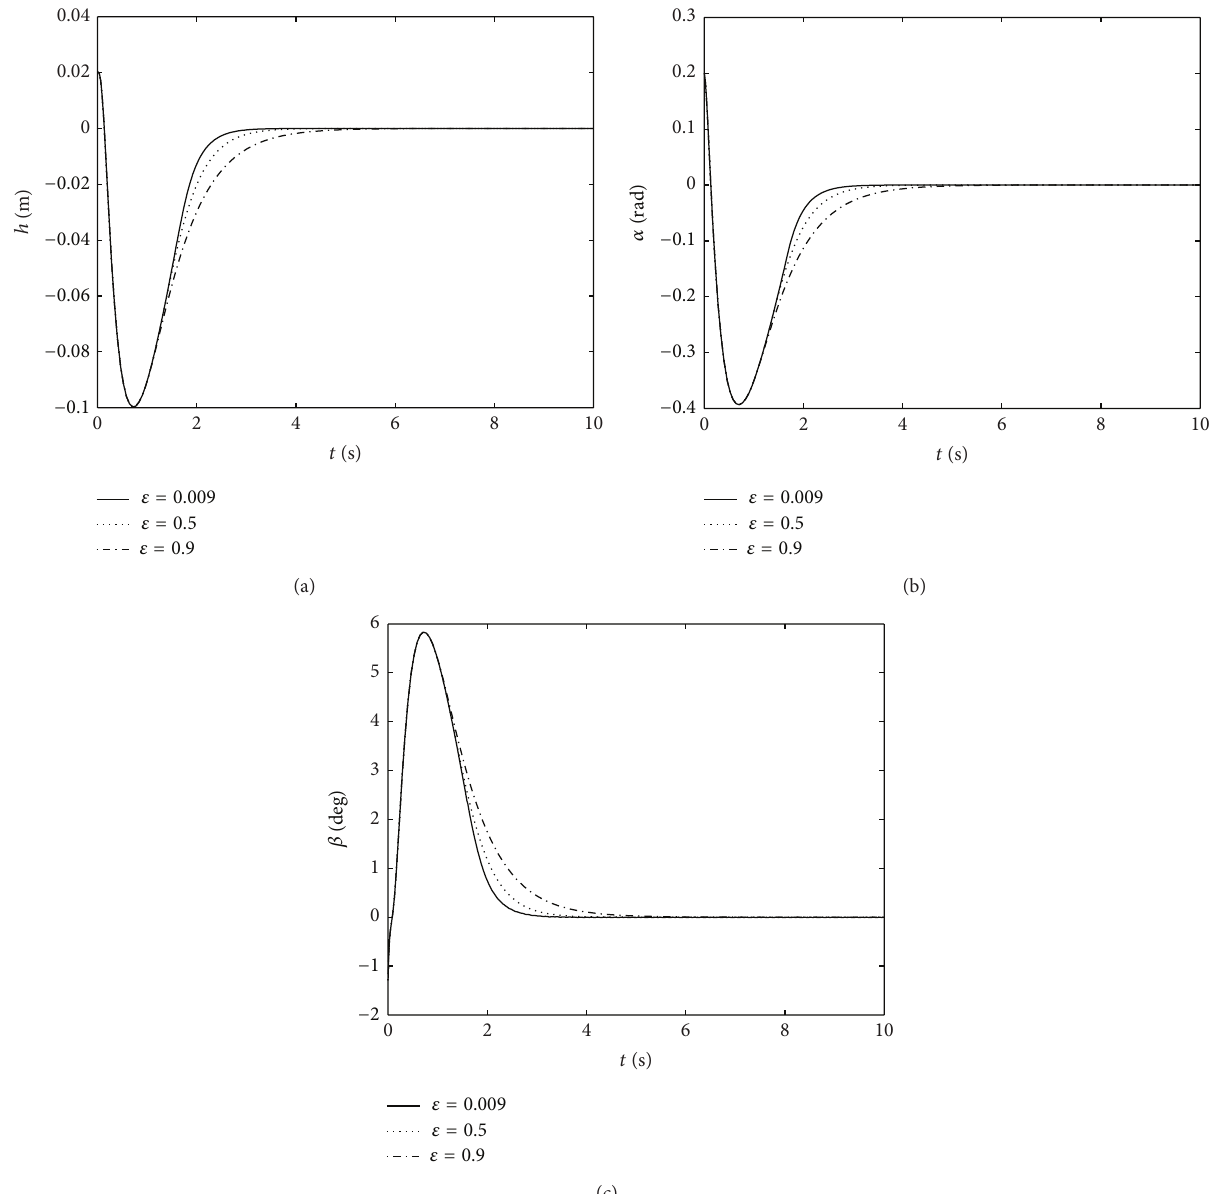
Figure 6: Nonlinear flutter control: 𝑈 = 13 m/s, 𝜌 = 0.05 . (a) Plunge. (b) Pitch. (c) Control